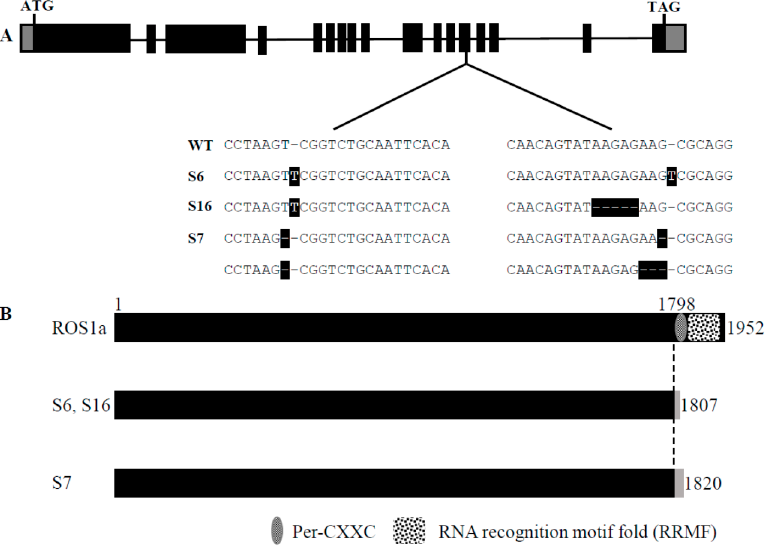
Figure 4. CRISPR/Cas9-induced OsROS1a gene modification in rice. ( A ) Schematic of OsROS1a gene structure. Exons and introns are denoted as black blocks and lines, respectively. The translation initiation codon (ATG) and termination codon (TAG) are shown. The recovered mutated alleles are shown below the wild-type reference sequence. The target sites nucleotides are indicated in black capital letters. The white dashes with black backgrounds indicate the deleted nucleotides. The white capital letters with black backgrounds indicate the inserted nucleotides. ( B ) Alignment of the protein sequence of ROS1a in mutant and wild type. The open reading frame (ORF) is 1952 amino acid residues in length in wild type. The dotted line indicates the frame shift mutation position because of the insertion or deletion of nucleotides due to the gene editing in mutants. The gray color indicates the positions where the premature stop codon was generated in the mutant alleles.